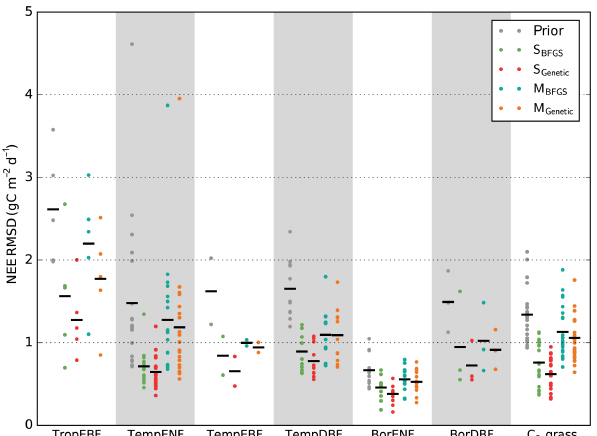
Figure 1. Model–data RMSD for the daily NEE time series at each site grouped by PFT. The prior RMSD values are shown in grey, followed by the median posterior RMSD values obtained within 16 optimisation tests with random first-guess parameter values for each optimisation method. Black horizontal bars show the mean value across the sites for each PFT.